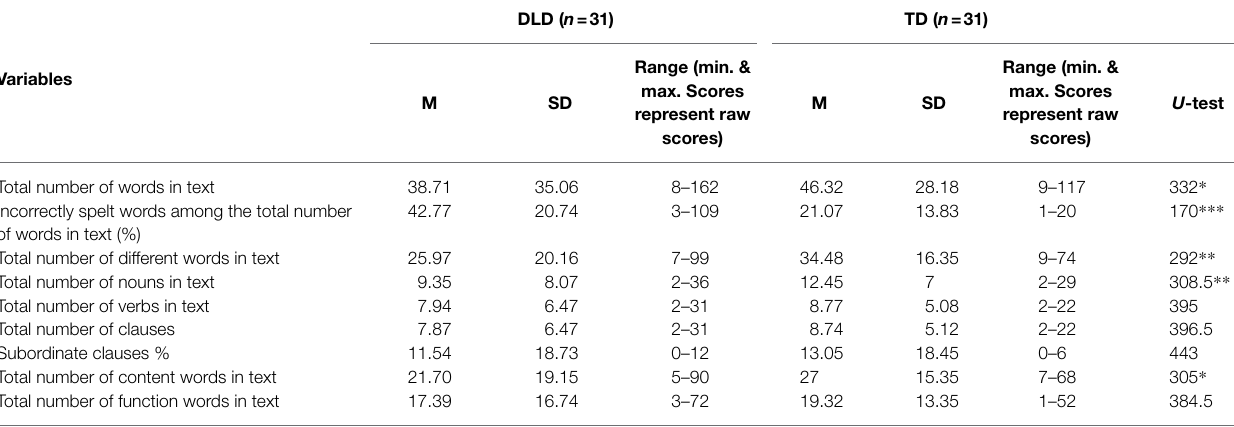
TABLE 2 | Descriptive statistics for the written text production measures per group.